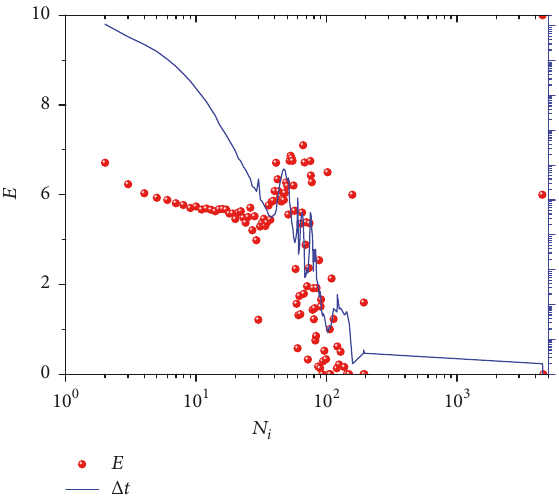
Figure 5: The change regulation of 𝐸 and Δ𝑡 at different 𝑁 𝑖 (with log scale) in the